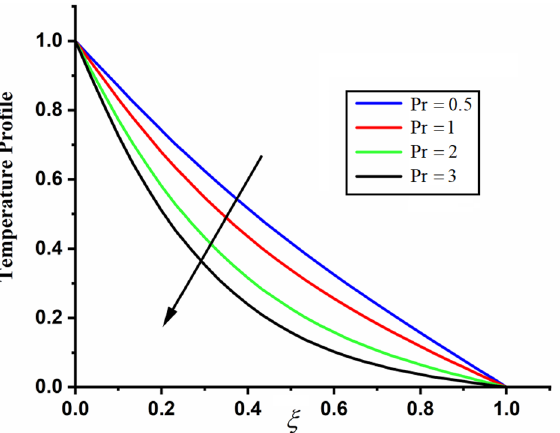
Figure 14. The impact of Pr on the temperature of couple stress fluid when, α = 0.3 , β = 0.3 , Re = 4 and t = 0.7 .